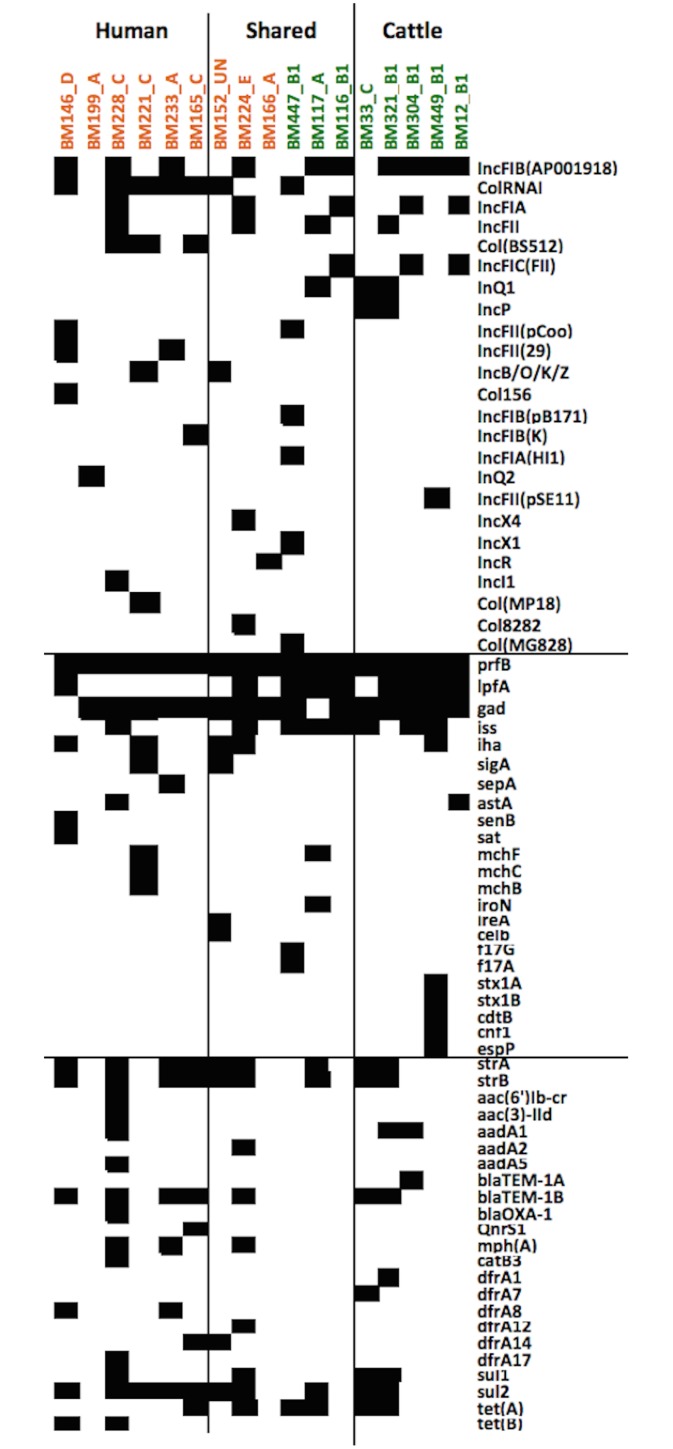
Virulence, resistance genes and plasmid replicons in 17 E. coli isolates.The presence of virulence, antibiotic resistance genes and plasmid replicons in 17 Escherichia coli genomes from cattle and cattle attendants in Tanzania in relation to their ERIC-PCR genotype, source of isolation and phylogenetic group. Black boxes show the presence and white boxes the absence of the relevant gene in each isolate. Isolates indicated with green were isolated from cattle, and isolates in orange—from human. Blocks indicate the host association of the strain based on ERIC-PCR.